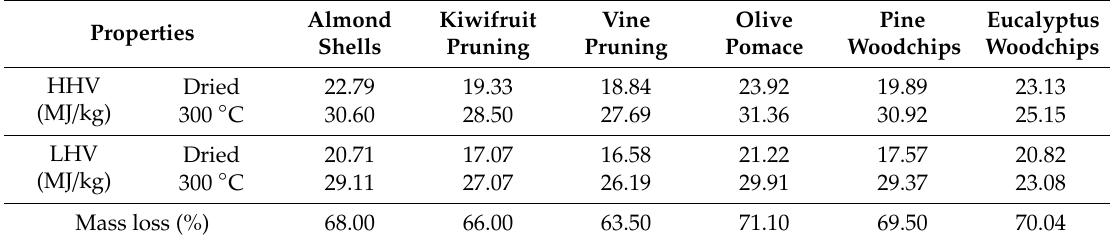
Table 4. High Heating Value calculated for the di ff erent biomass waste